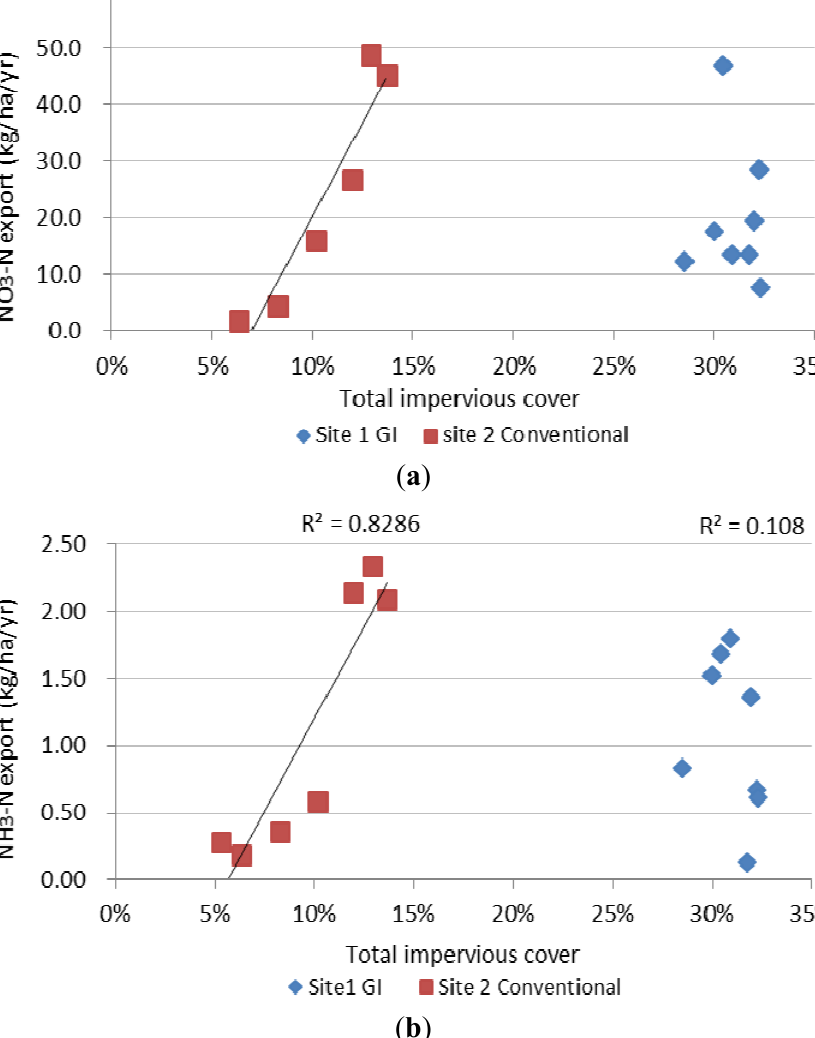
Figure 11. Annual loadings of nutrient exports from Site 1 (Panther Creek watershed, The Woodlands green infrastructure development) and Site 2 (Bear Creek watershed, conventional development), 2002–2009: ( a ) NO